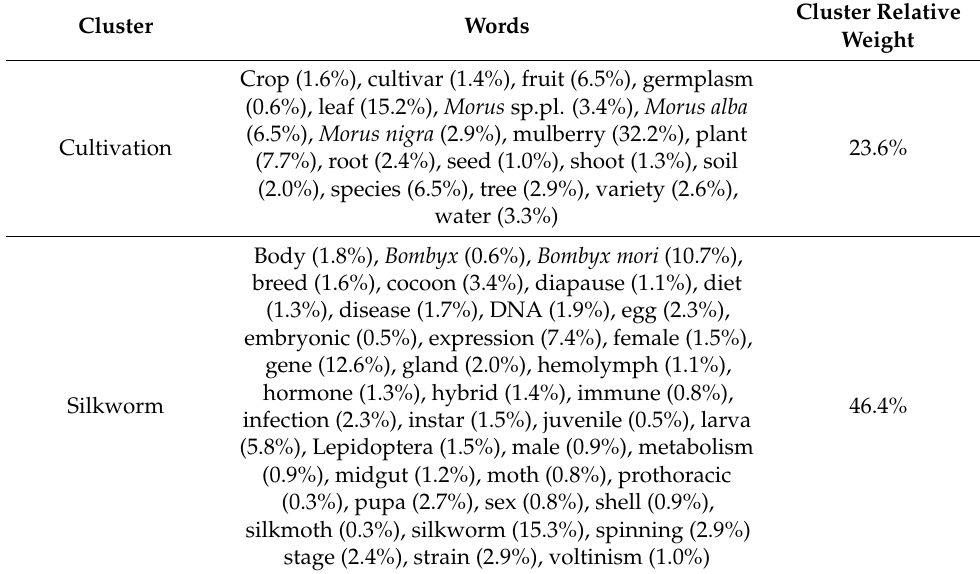
Table 6. Clusters composition with the relative weight of each word and the overall relative weight of each cluster.